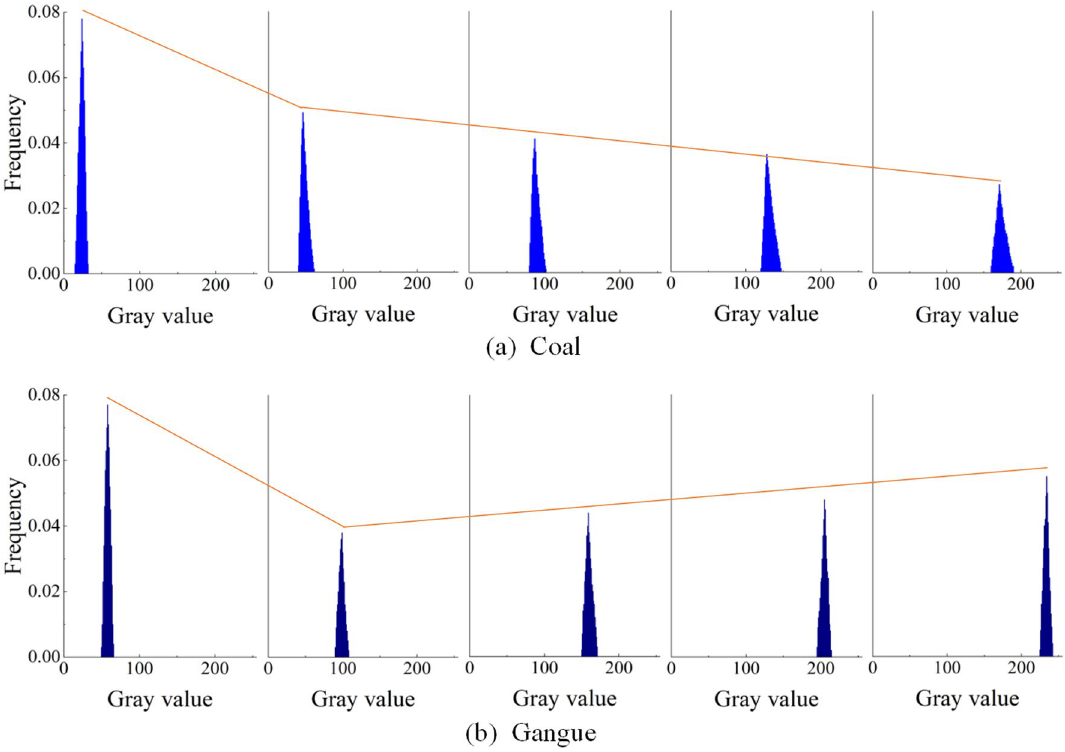
Figure 3. Gray distribution histogram of coal and gangue